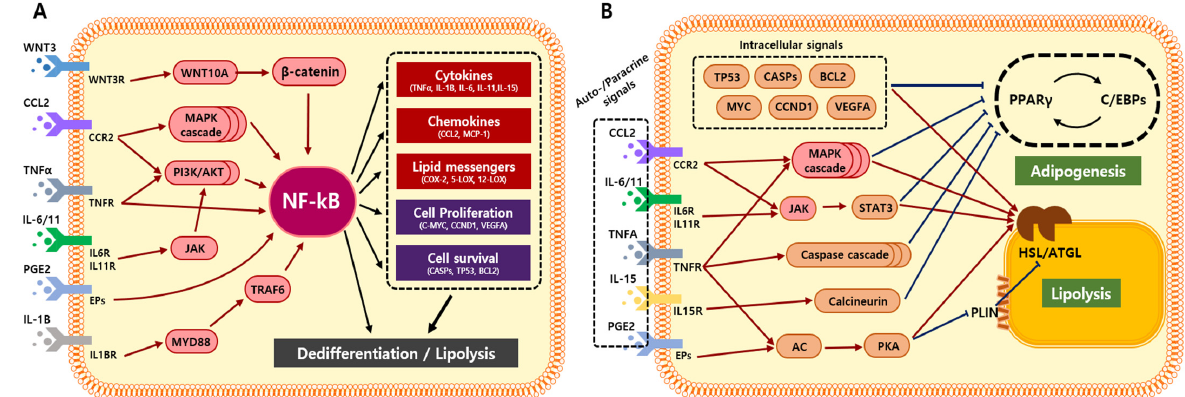
Figure 4. Summary of NF- κ B mediated signal transduction regulating adipogenesis and lipolysis.